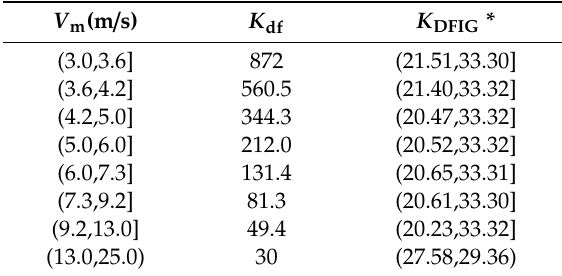
Figure 9. The K DFIG under di ff erent wind speeds with a fixed K df , the solid lines for the fixed pitch angle mode (Mode 1), the dashed line for the fixed rotor speed mode (Mode 2). Table 1. The optimized droop coe ffi cient under di ff erent wind speeds, brackets for containing upper or lower limit, parentheses for excluding upper or lower